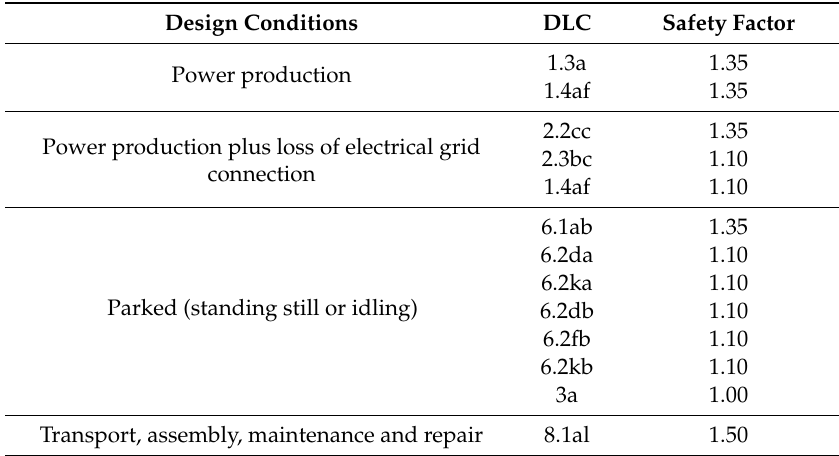
Table 6. Design load cases according to the IEC design